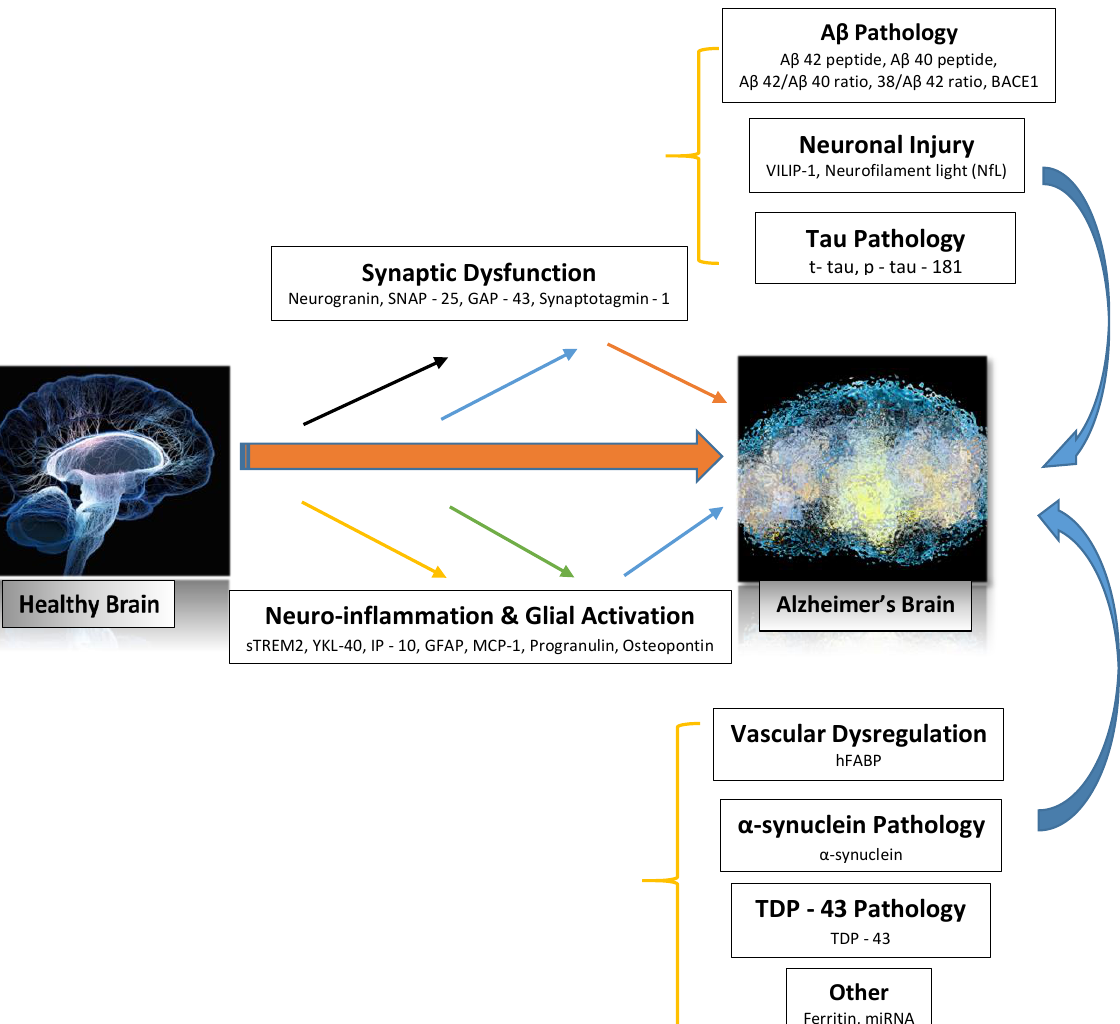
Figure 2. Pathological events and their cerebrospinal fluid biomarkers in Alzheimer’s disease.